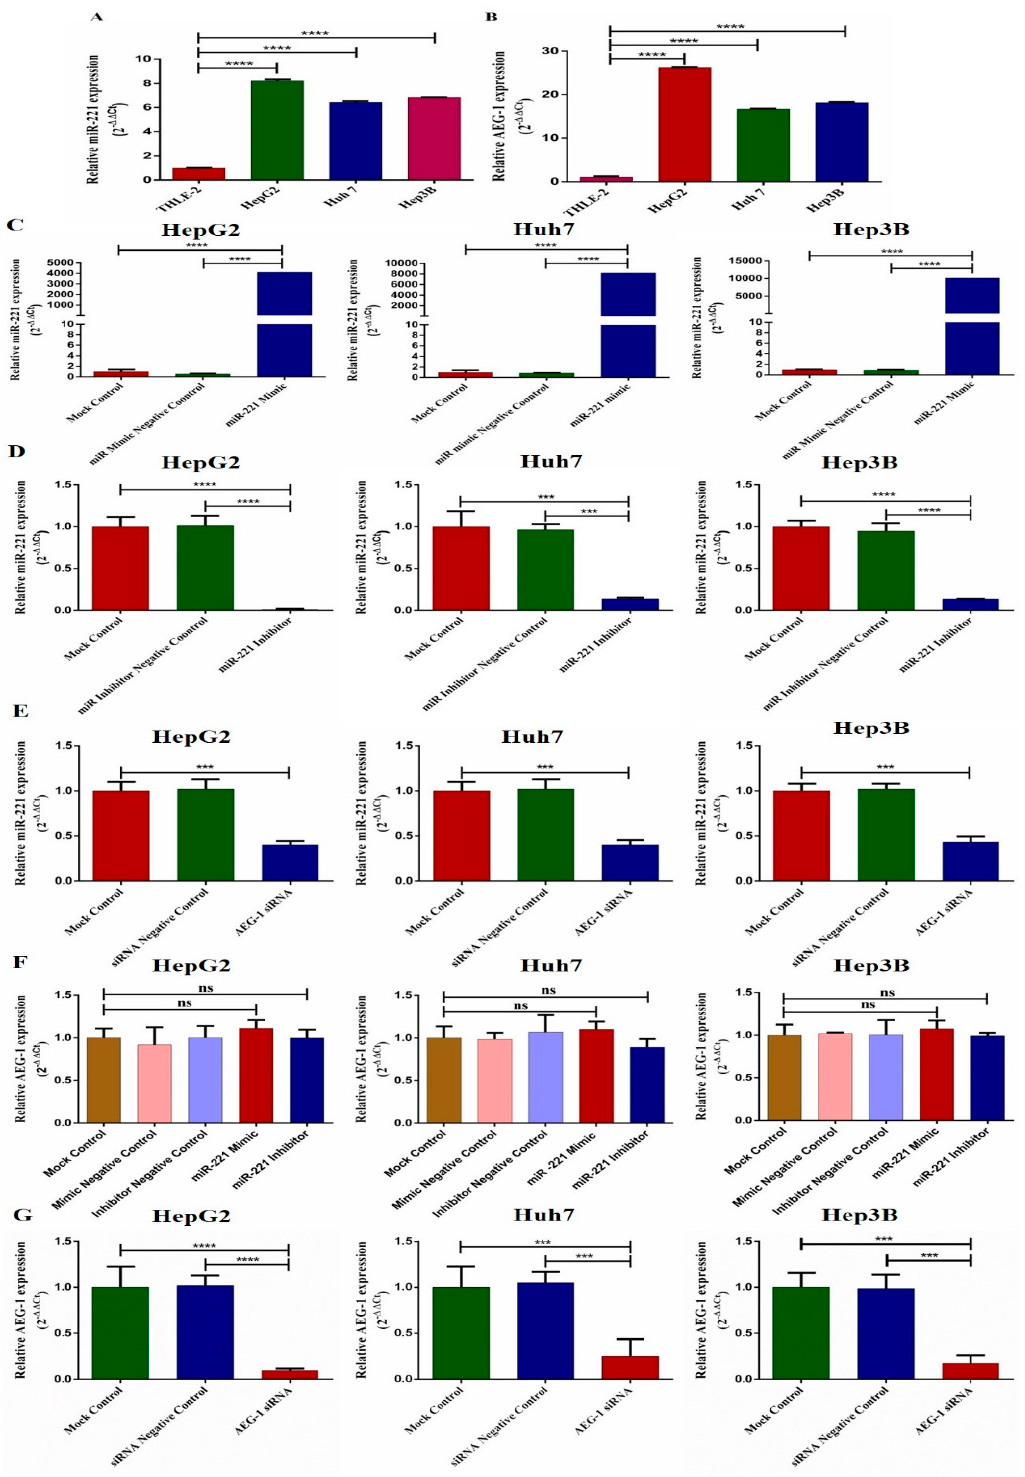
Figure 2. The relative miR-221 and AEG-1 mRNA levels in HCC cell lines. The miR-221 ( A ) and AEG-1 ( B ) relative mRNA levels analyzed in HCC cell line panels, the relative miR-221 expression in miR-221 mimic- ( C ), miR-221 inhibitor- ( D ), and AEG-1 siRNA- ( E ) transfected HCC cells. The relative mRNA levels of AEG-1 in miR-221 mimic/inhibitor- ( F ) and AEG-1 siRNA-transfected groups in HCC cells ( G ). The RNU6 and GAPDH were used as internal controls. Error bars presented as mean ± s.d and p -values represented as *** p < 0.001, **** p < 0.0001. ns represented as